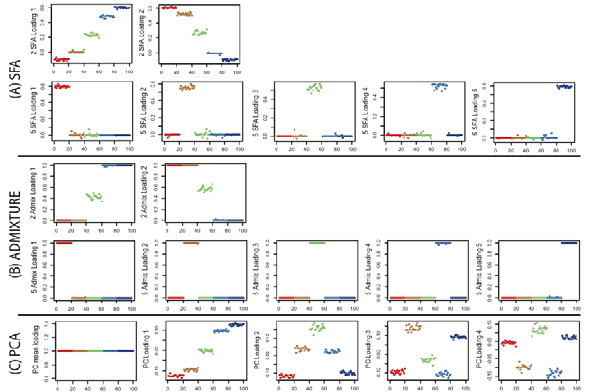
Figure 8. Results from SFA, ADMIXTURE , and PCA for the clustered 1-D simulation. All plots show the individuals on the x -axis (colored and ordered by location with respect to the 1-D clustered isolation-by- distance model) plotted against the estimated loadings.